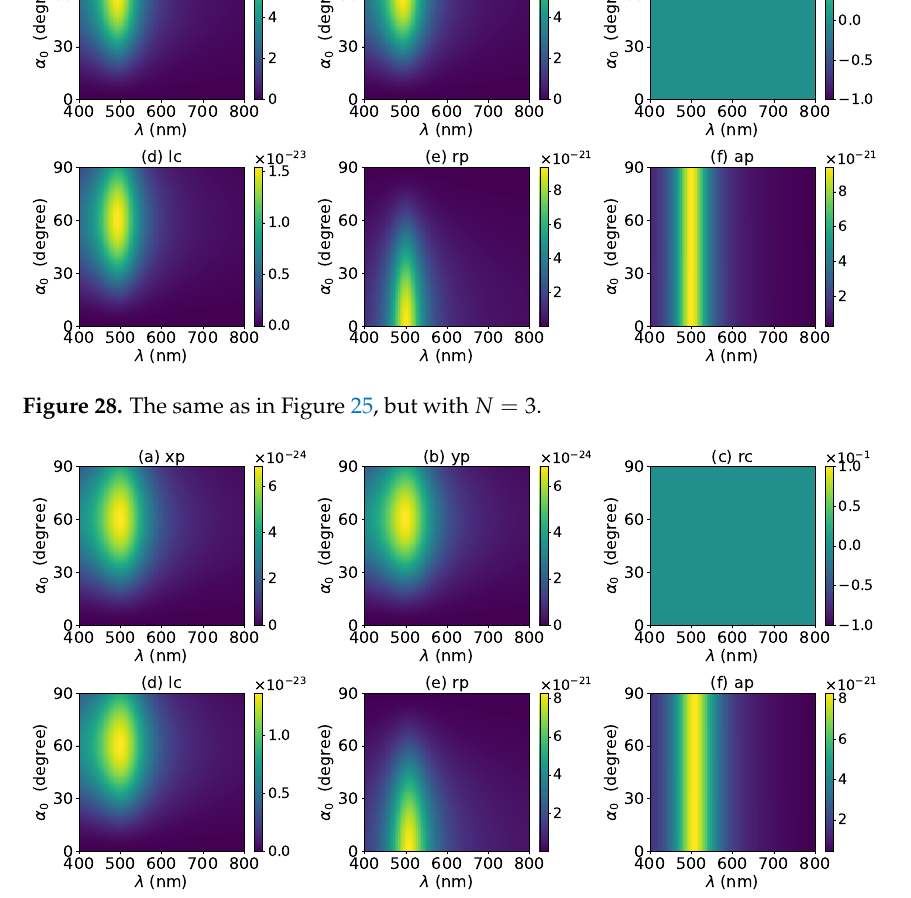
Figure 29. The same as in Figure 25, but with N =